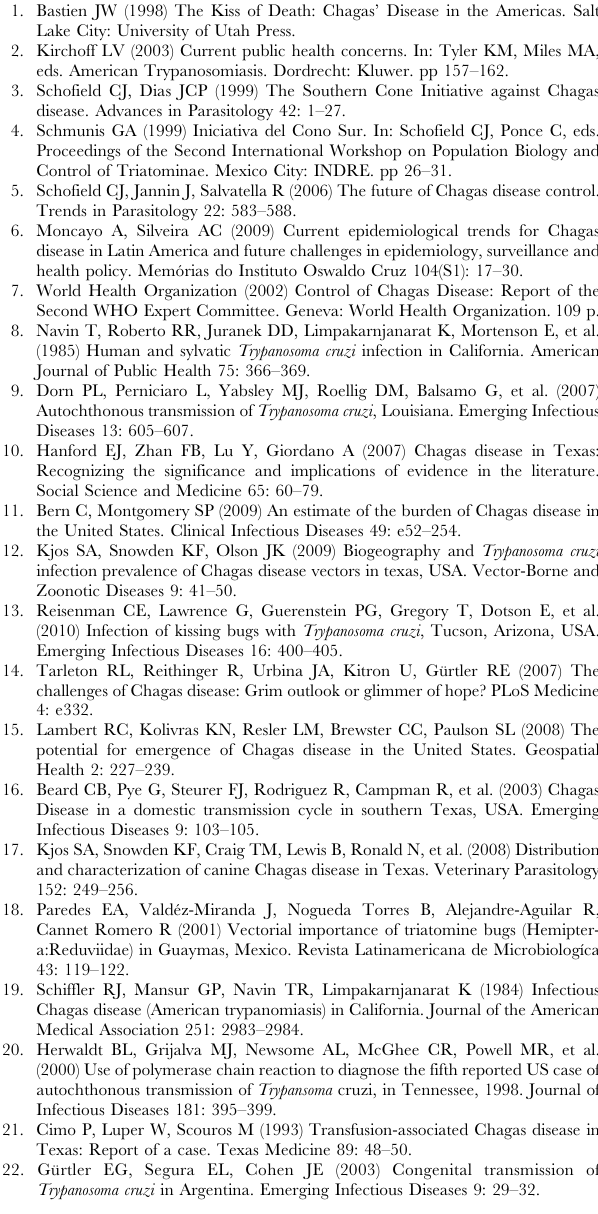
Table S1 Trypanosoma cruzi incidence in Texas by county. Table S2 Species records in the Disease Vectors